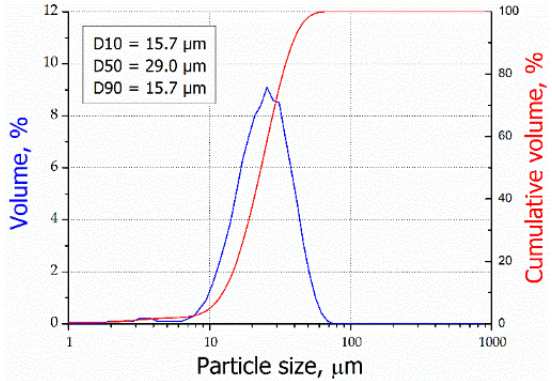
Figure 1. Particle size distributions of the M789 powder.